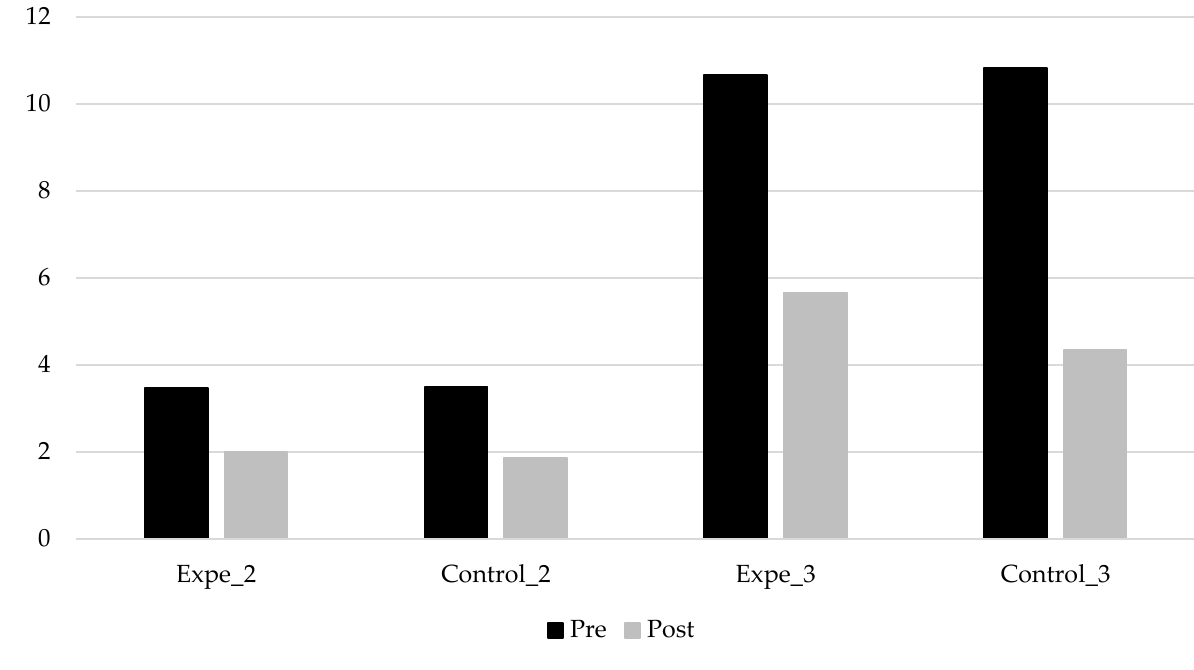
Figure 4. Mean of non-produced phonemes in the pretest and post-test depending on the severity of articulation difficulties (moderate difficulties: 2; severe difficulties: 3).